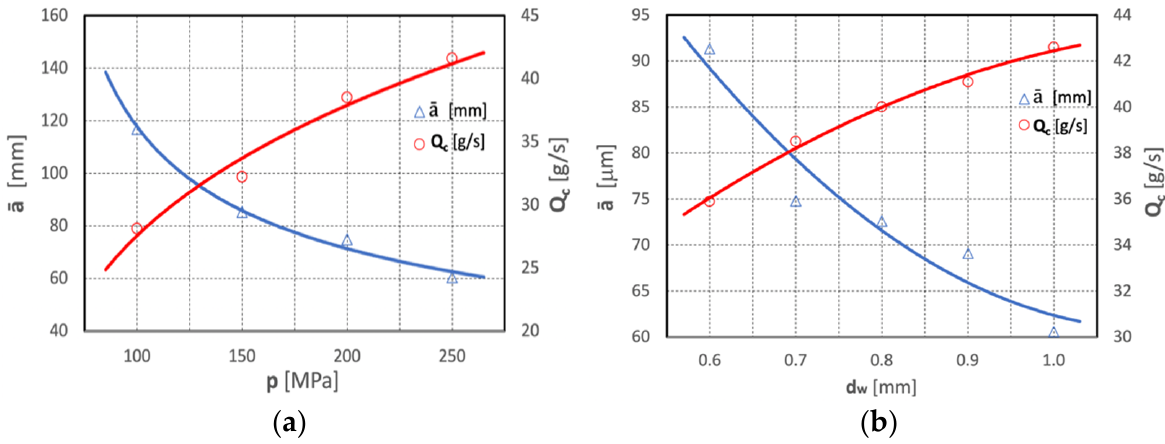
Figure 5. Effectiveness of the comminution process and efficiency of hydro-jet milling for hard coal in relation to: ( a ) pressure, at water nozzle diameter d w = 0.7 mm, and ( b ) water nozzle diameter, at p = 200 MPa. Common test conditions: d c 1 = 2.4 mm, s = 10 mm.